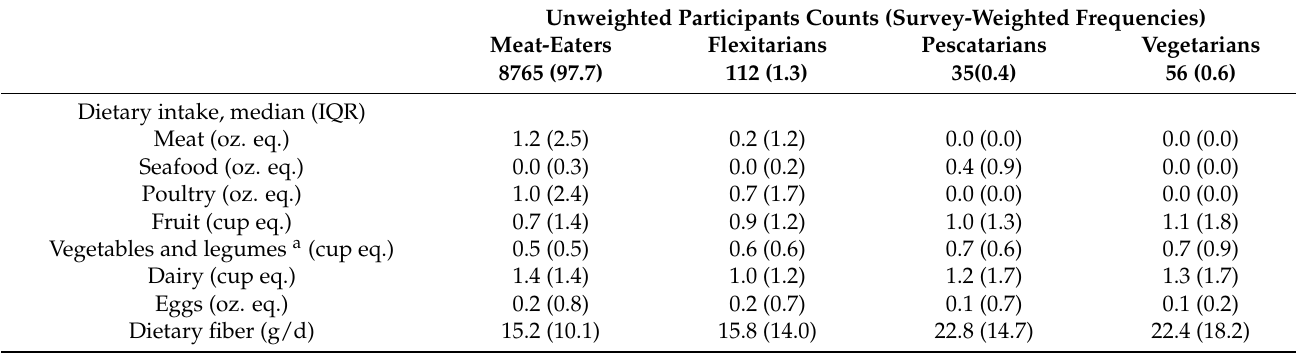
Table A2. Survey-weighted serum parameters of NHANES 2007–2010 study participants following a meat-eating, flexi- tarian, pescatarian or vegetarian diet (n = 8885 a ).